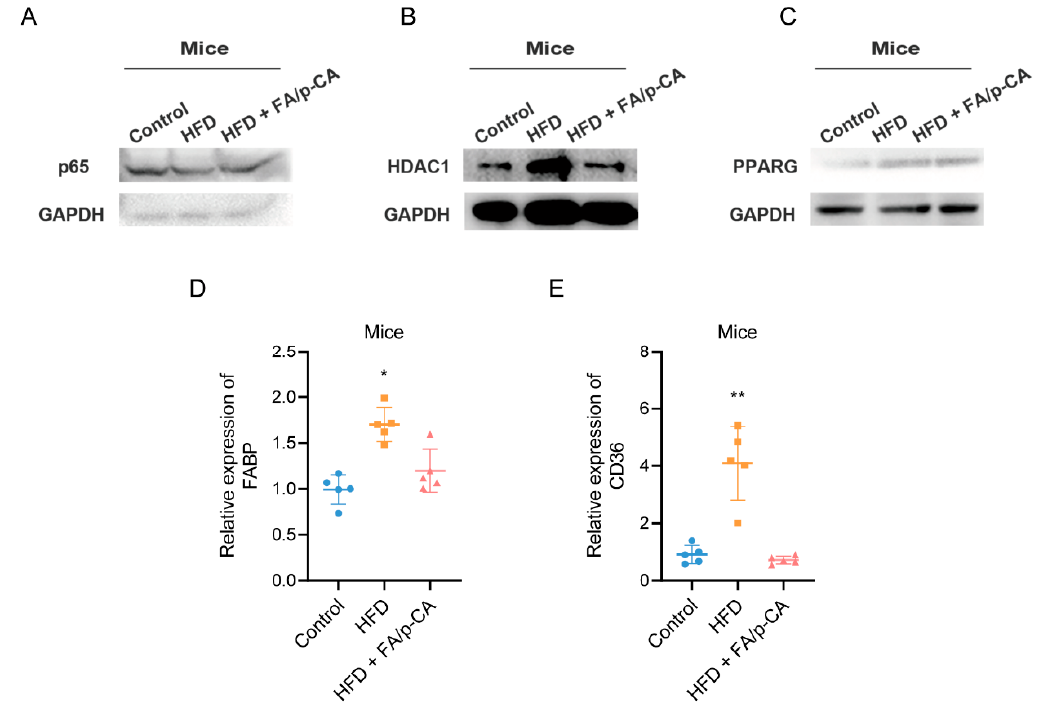
Figure 7. FA/p-CA inhibit hepatic lipid uptake via the HDAC1/PPARG axis in vivo. ( A – C ) Mice were treated with FA/p-CA, then expressions of p65 ( A ), HDAC1 ( B ), and PPARG ( C ) were determined by Western blot. ( D , E ) FA/p-CA were administered by gavage; expressions of FABP and CD36 were determined by qRT-PCR. Data represented as mean ± SD. Compared to control, * p < 0.05, ** p < 0.01.